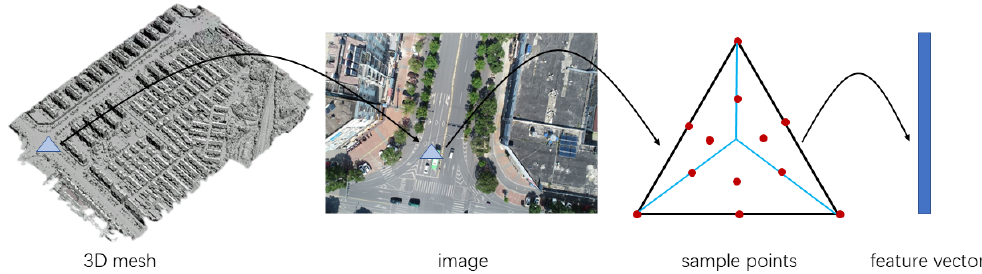
Figure 1. Schematic diagram of feature vector generation. From left to right is a triangle T i of 3Dmesh, T i in the projection area R k of the visible image I k , the sampling points in the R k area, and the final feature